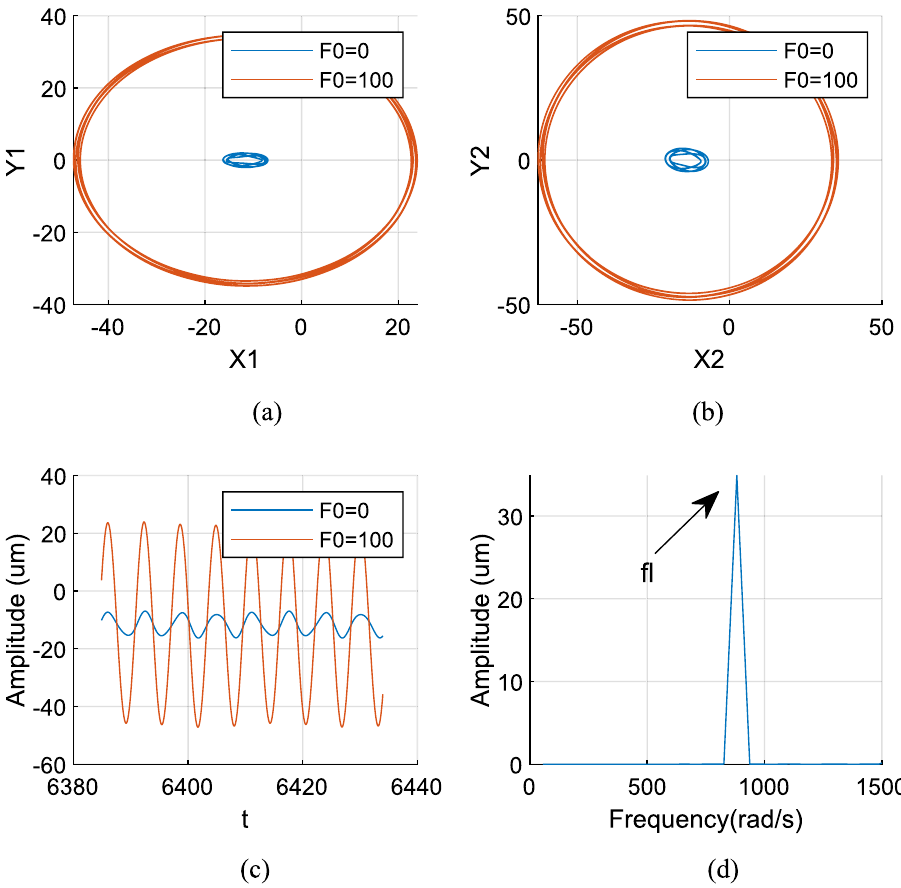
Figure 15. First order primary resonance of LP rotor (λ = 1. 75, ω l = 882 rad/s) ( a ) Orbit diagram of LP rotor ( b ) Orbit diagram of HP rotor ( c ) Time history ( d ) Frequency spectrum.